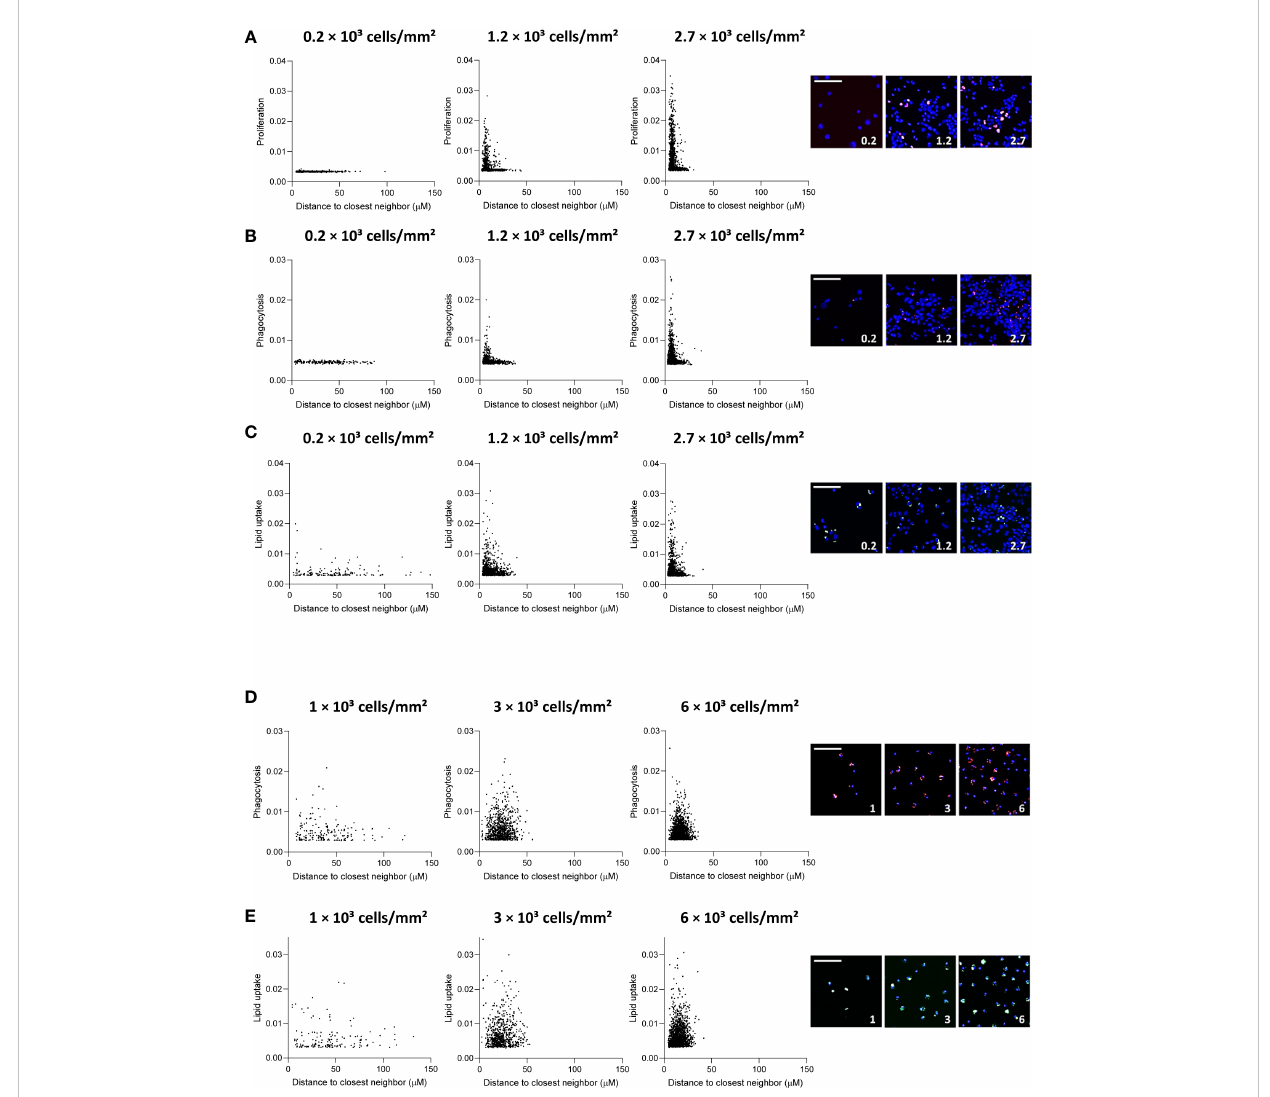
FIGURE 3 Distance to neighboring cells in fl uences THP-1 function. Distance to closest neighbor was plotted against mean fl uorescence intensity (MFI) per cell for proliferation (A) , phagocytosis (B) and lipid uptake (C) assays in THP-1 M F , and (D) phagocytosis and (E) lipid uptake assay in primary MDM, for 3 plating densities each. The scale bar corresponds to 50 m